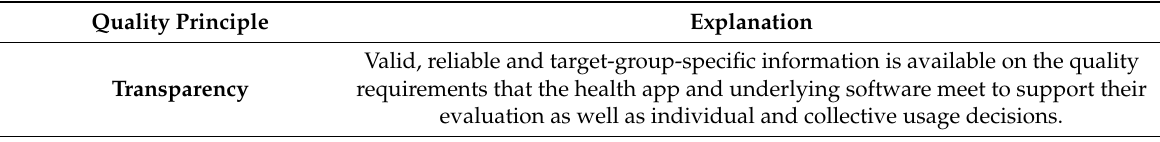
Table 1. Detailed explanation of the nine central quality principles for medical apps, as proposed by